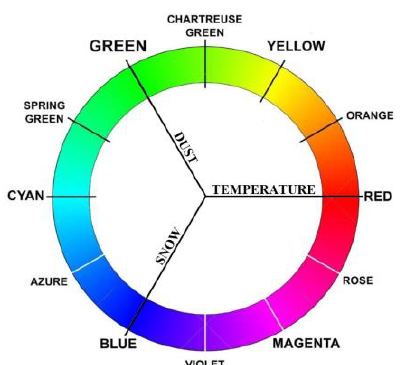
Figure 8. Color wheel of RGB display of Fig. 7. Pixels significantly affected by temperature, dust and snow will be displayed in red, green and blue, respectively. Meanwhile, yellow, magenta and cyan, respectively. (Original image taken from